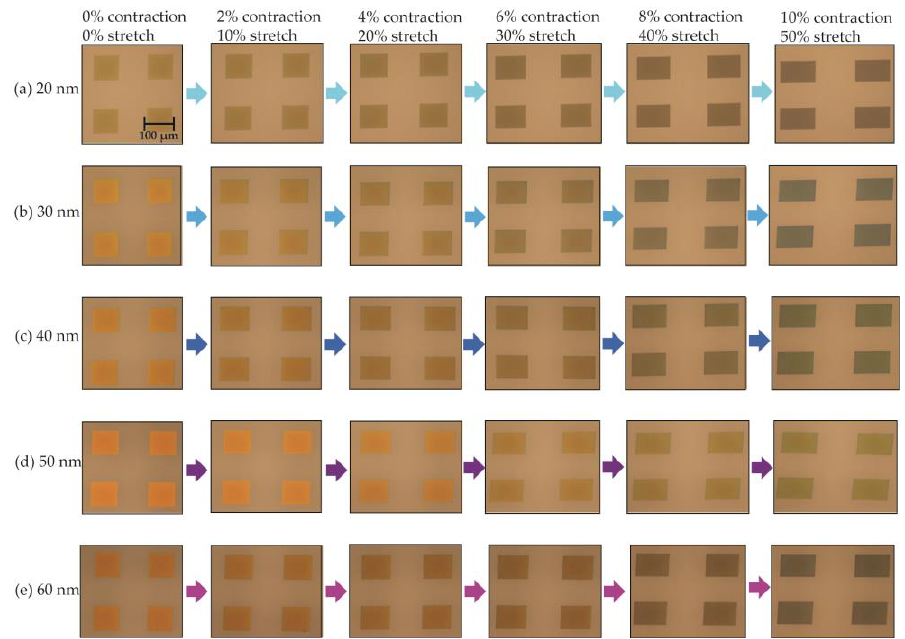
Figure 7. Optical microscopic images of the visible color change due to applied lateral strain on the PDMS membrane involving up to 50% stretching in the lateral direction, and 10% contraction in the vertical direction, with hierarchical Ag structures of different thicknesses of ( a ) 20 nm, ( b ) 30 nm, ( c ) 40 nm, ( d ) 50 nm, and ( e ) 60 nm.